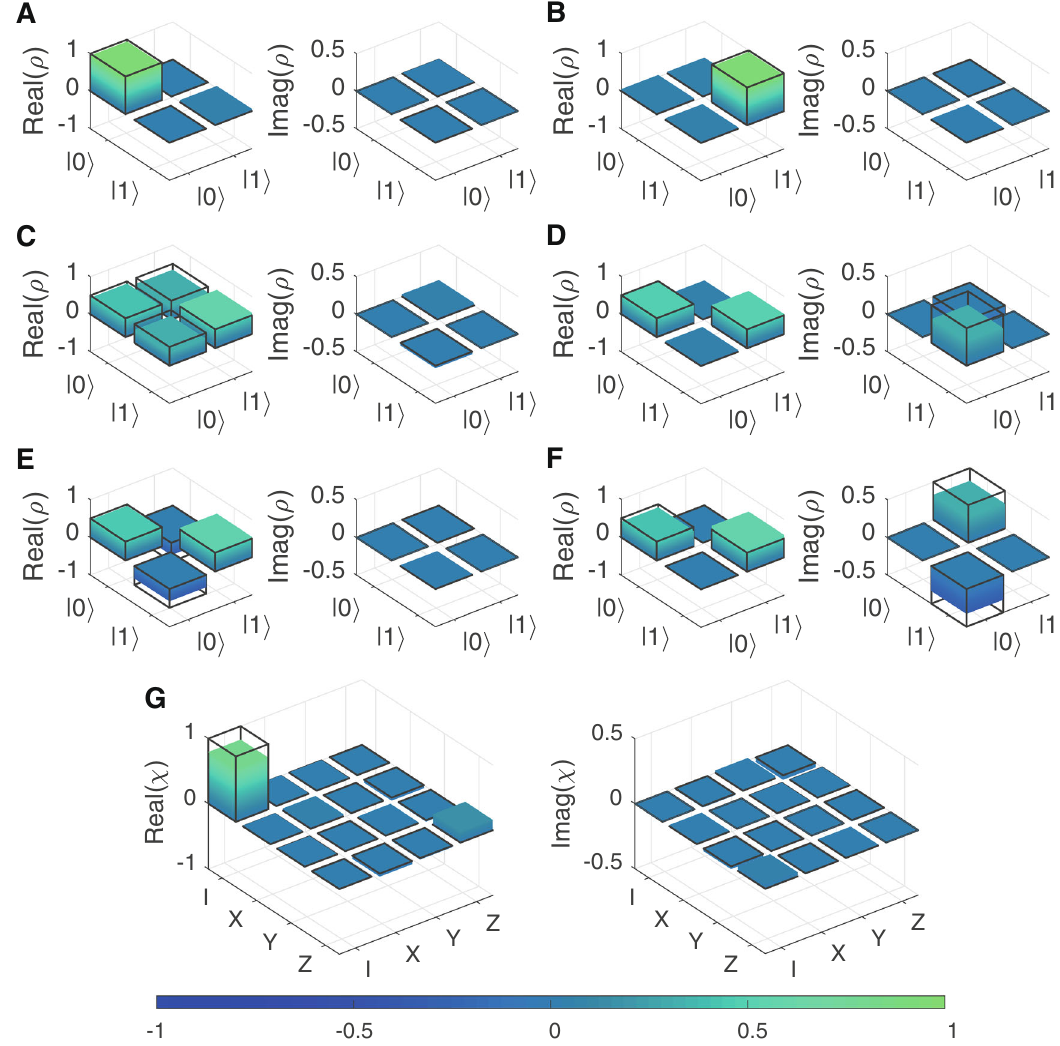
Fig. 3 Quantum state and process tomography of a successful reset. The free-evolution Hamiltonian is I , and the deterministic interaction is ffiffiffi p U ¼ ð X (cid:3) Z þ i Y (cid:3) X Þ = 2 . a – f The density matries of target qubit after resetting with initialization to each axis of the Bloch sphere: Alphabetically, 0 j i , 1 j i , þj i , i j i , (cid:2)j i and (cid:2) i j i . The corresponding state fi delities are 0.946, 0.951, 0.840, 0.815, 0.823, and 0.829,